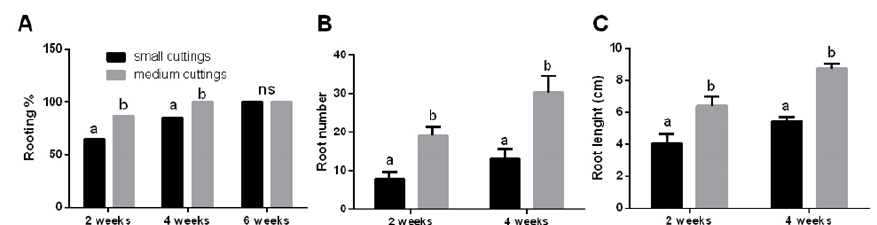
Figure 2. Effect of cutting size on the rooting percentage ( A ), root number ( B ) and length in pitaya ( C ) (summer-spring season). For each parameter and each group considered, columns labeled with different letters are significantly different (at p < 0.05). Student’s t -test was used to compute the pair-wise comparisons between group means.